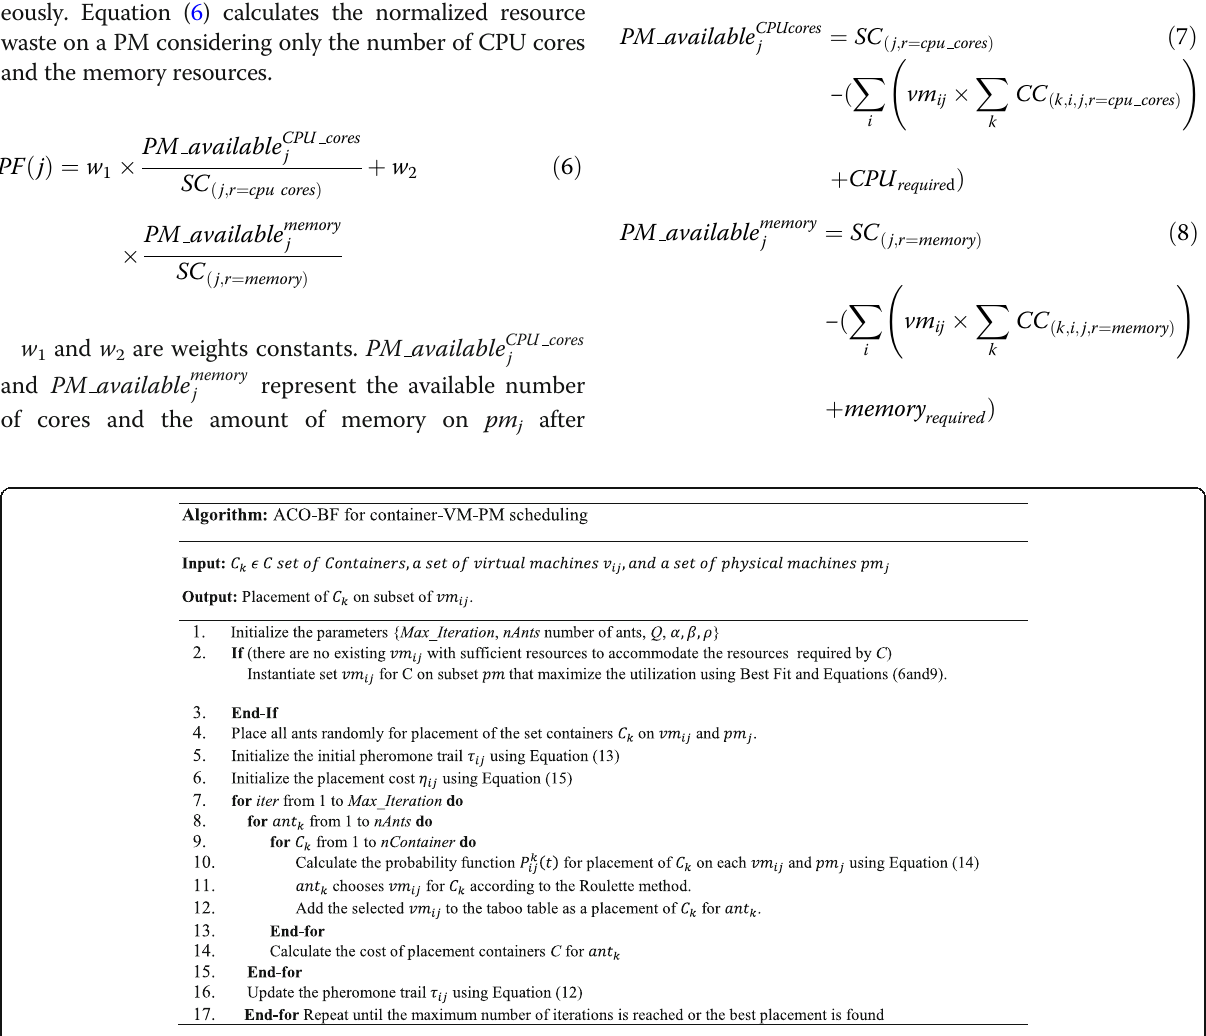
Fig. 7 The ACO algorithm for container-VM-PM placement